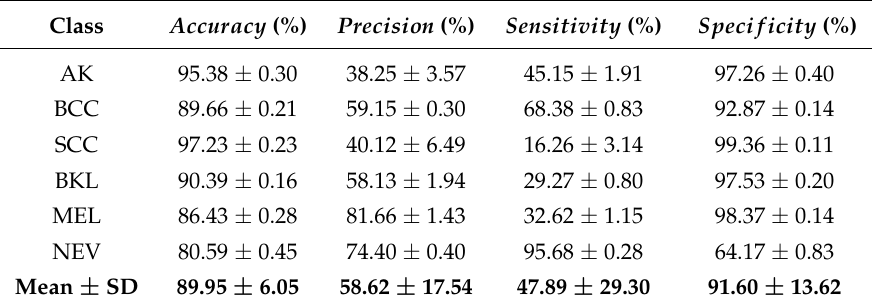
Table 9. Mean ± SD of five performance metrics for the test dataset of the Exp-4 with α = 1.6. The test dataset has 7452